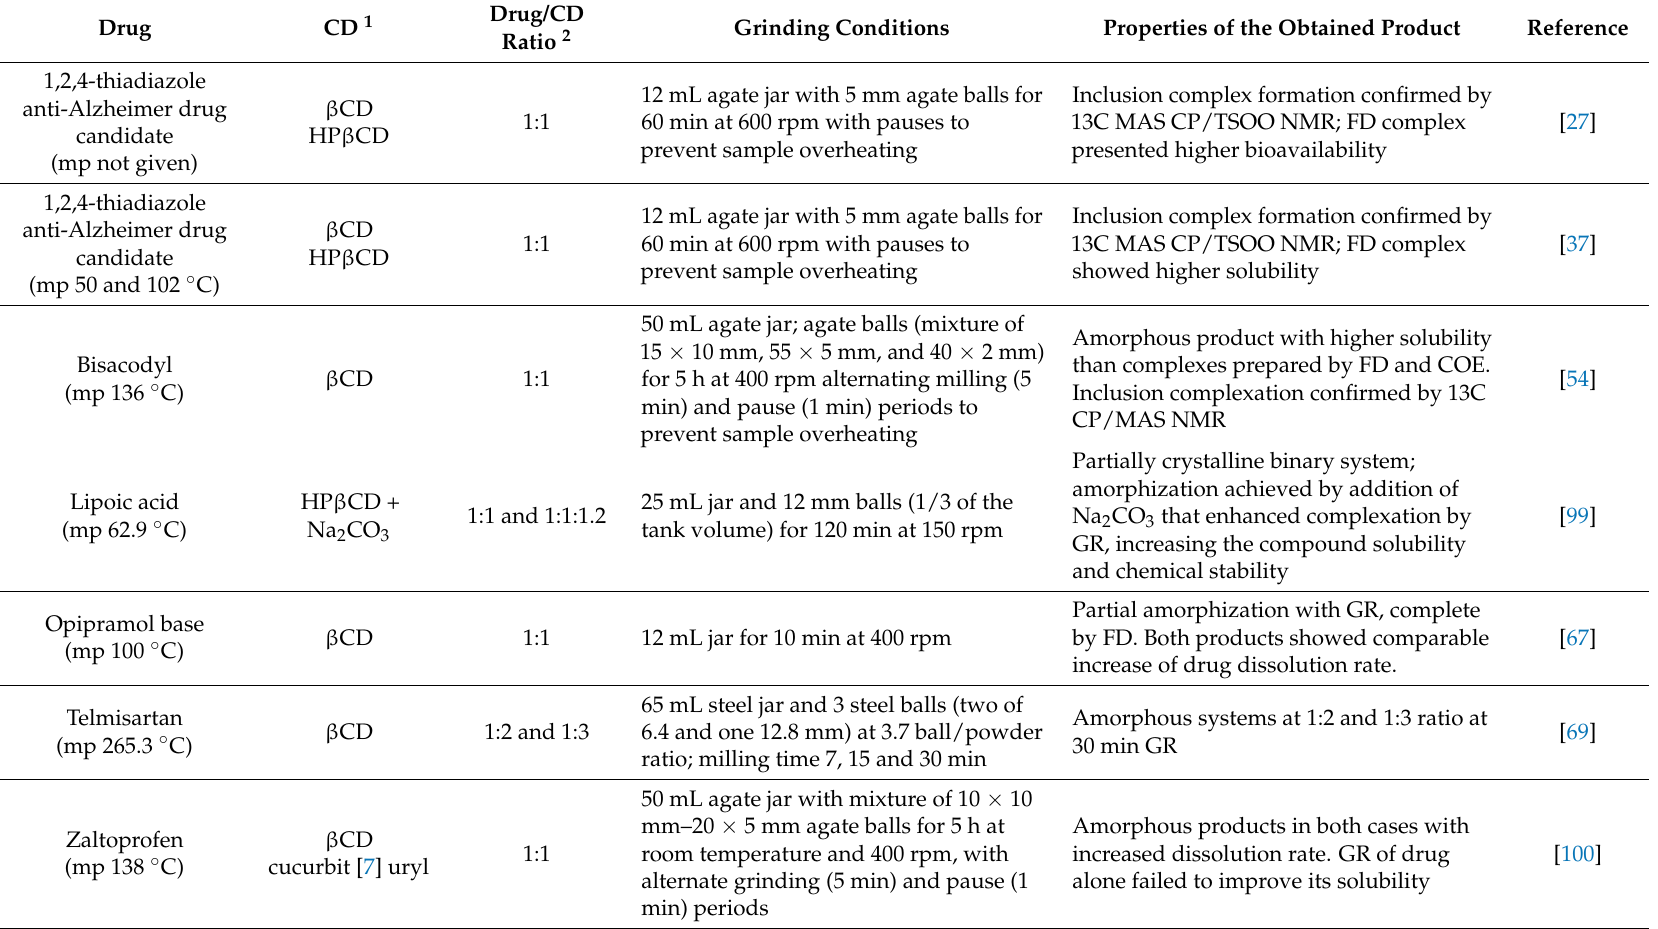
Table 4. An overview of drug/CD complexes prepared by grinding using planetary